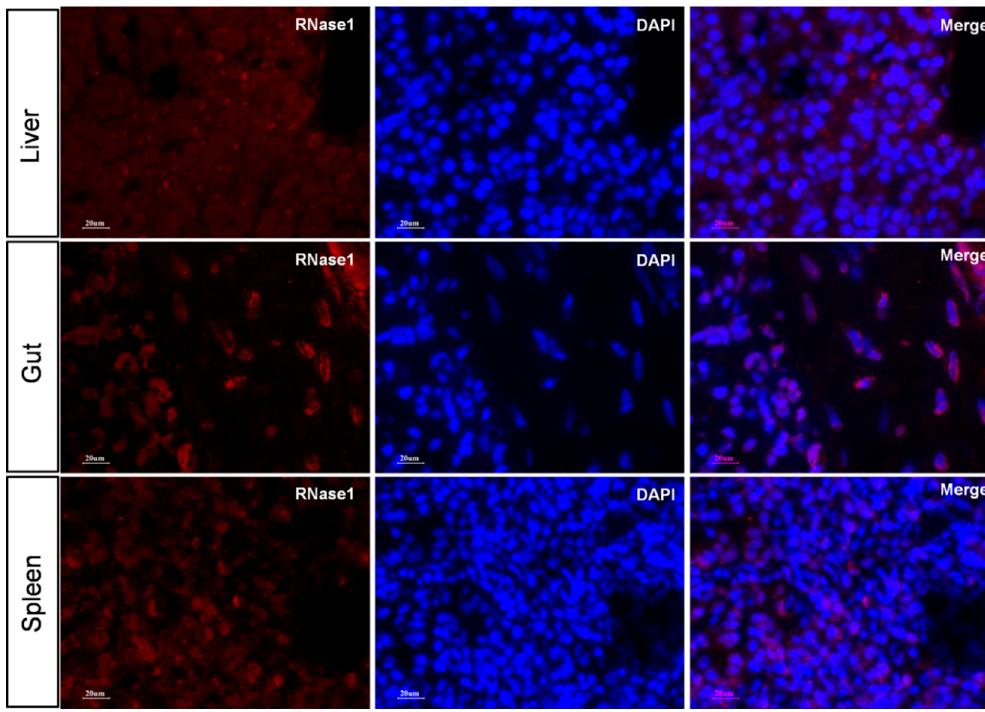
Figure 6. Immunofluorescence analysis demonstrates RNase1 production in the liver, gut and spleen tissues of two-year-old M. amblycephala . Immunofluorescence staining identifying cells with RNase1 expression in red and nuclei in blue.